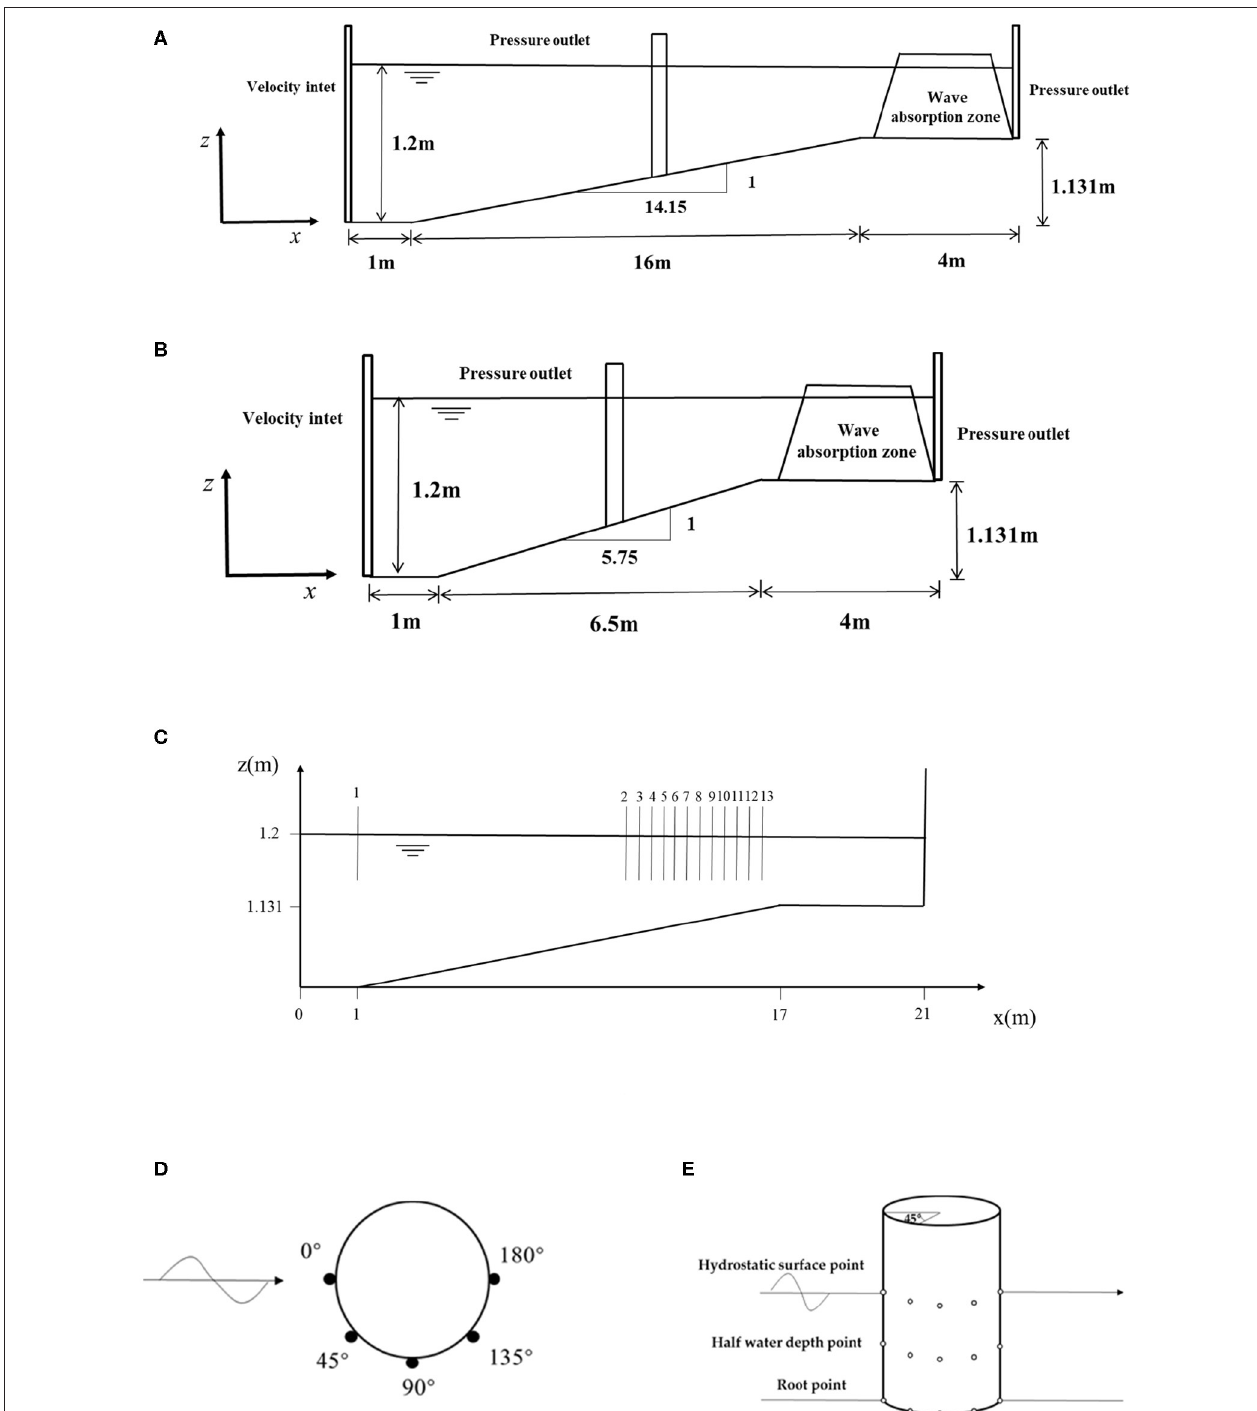
FIGURE 2 | Schematic of the numerical wave tank: (A) Model 1; (B) Model 2; (C) locations of wave gauges; (D) top view of the pressure and wave gauges; (E) front view of the pressure